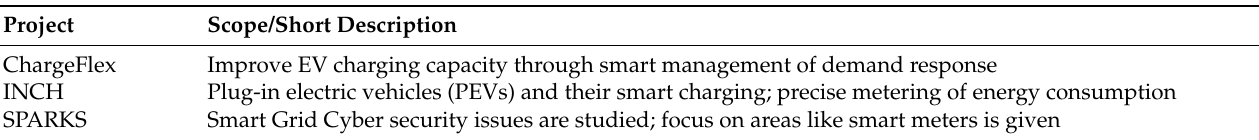
Table 10. Other applications: EV charging, cyber